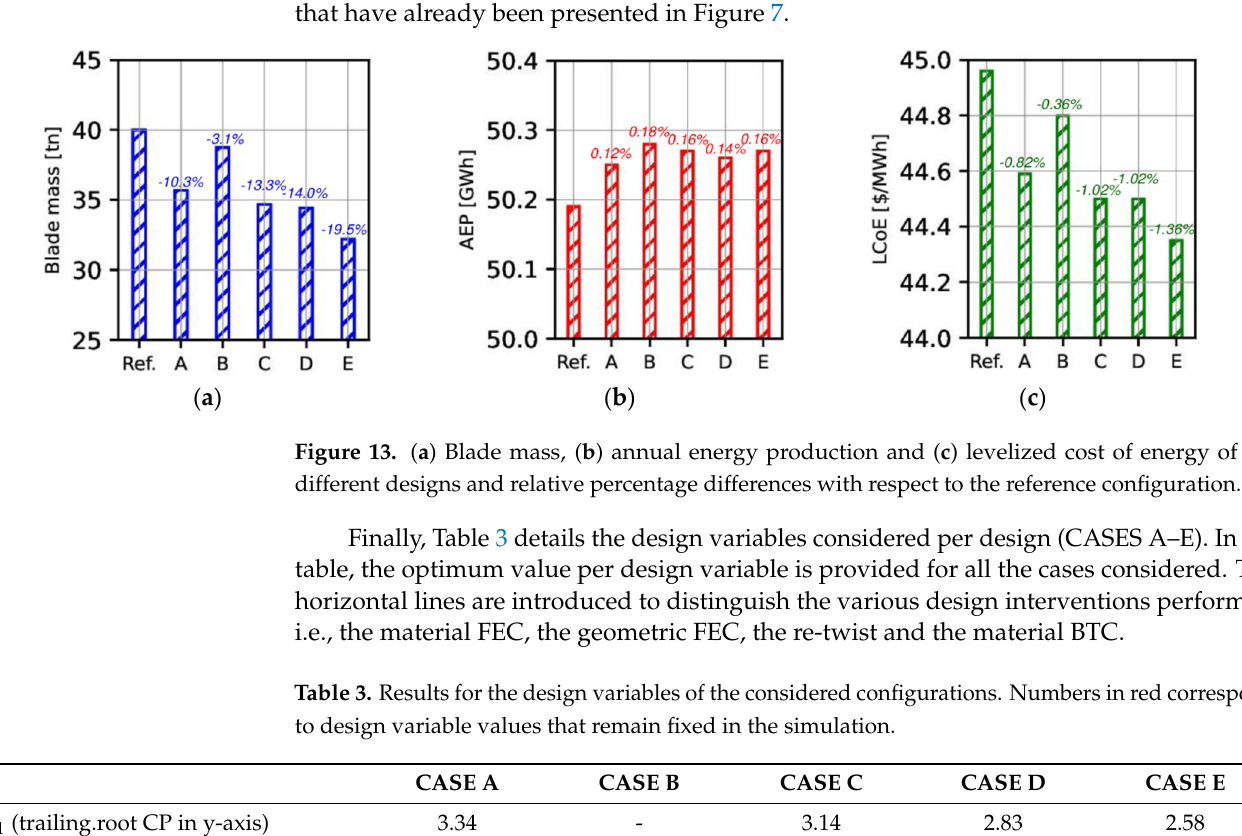
Figure 12. CASE E: distribution of ( a ) FEC material approach, ( b ) FEC geometrical approach, ( c ) twist and ( d ) offset ply angle of ‘UNIAX’ material and coefficient of wall thickness.